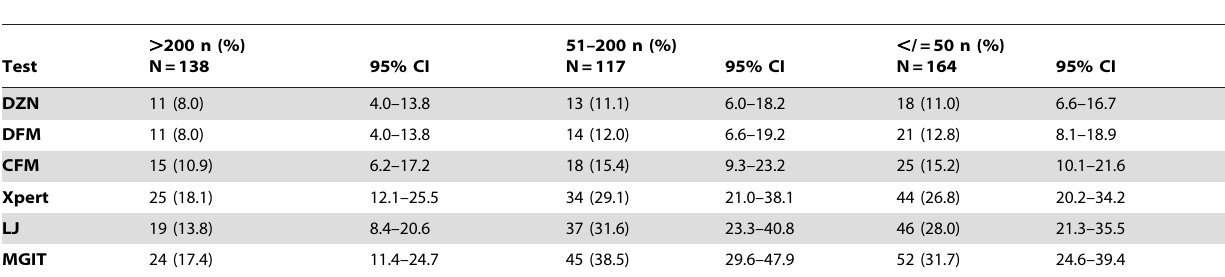
Table 4. Overall yield of tests, by CD4 cell count at study enrollment (n= 419).